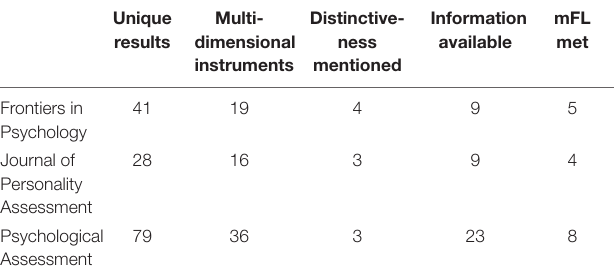
TABLE 1 | Unique results of the literature